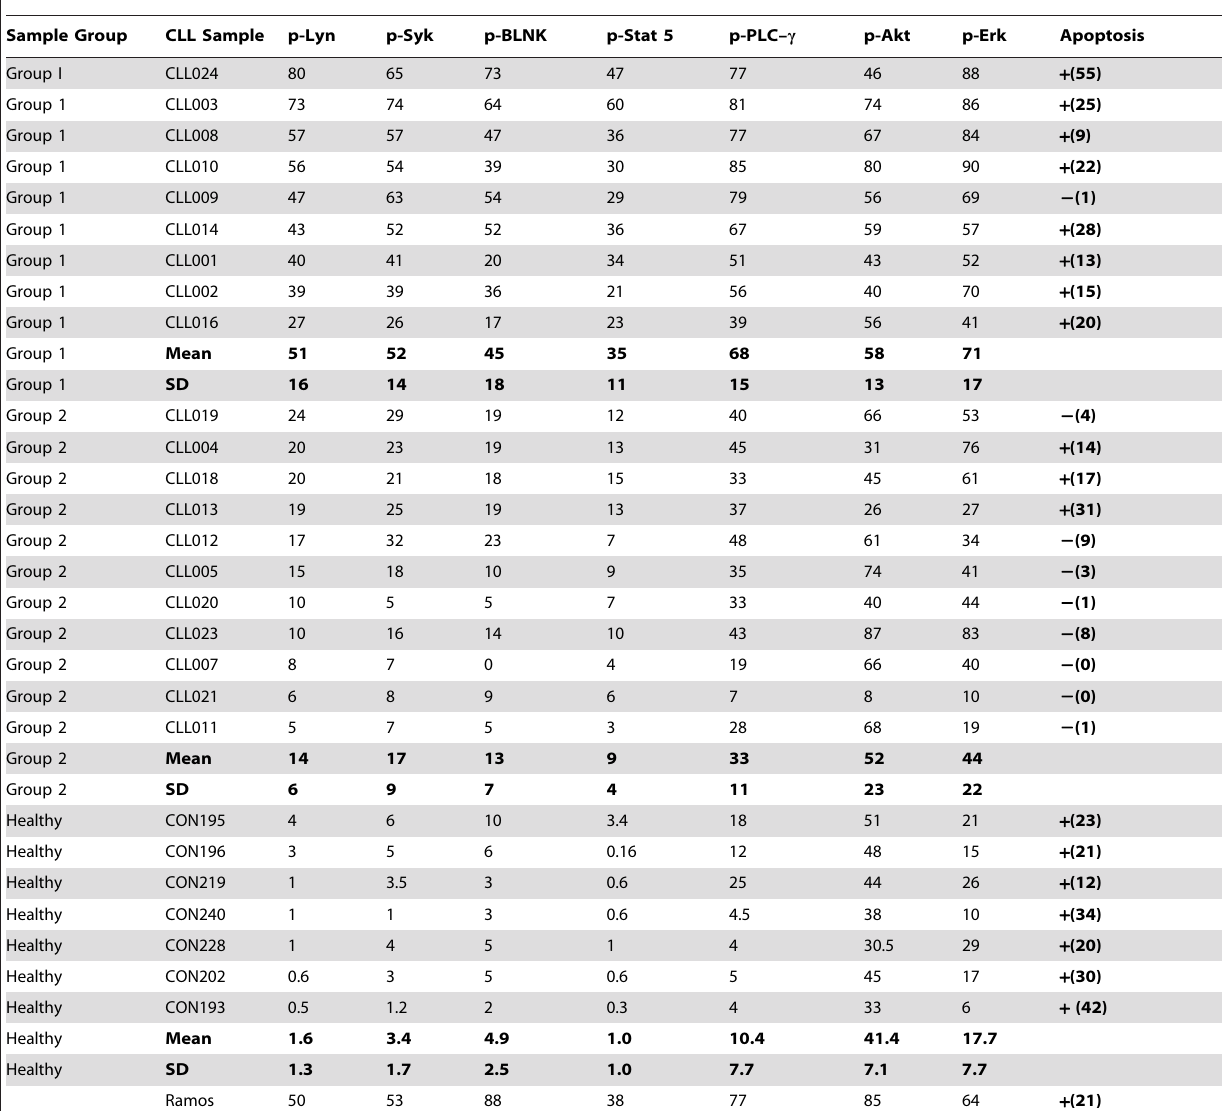
Table 3. BCR and apoptosis responses in CLL and healthy B cells.